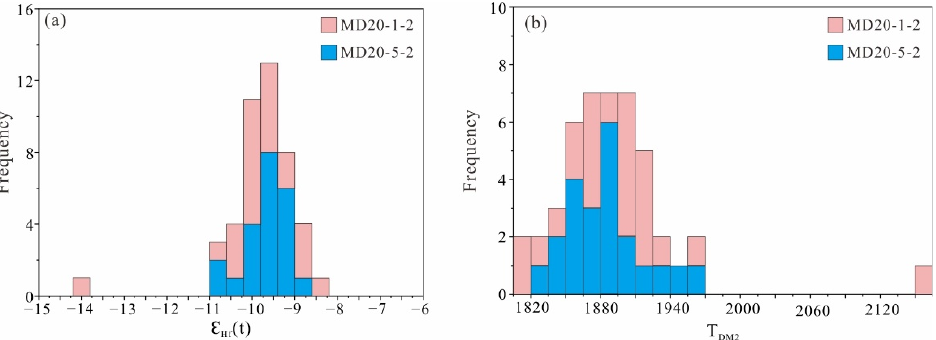
Figure 7. Chondrite-normalized REE patterns ( a ) and primitive mantle-normalized trace element patterns ( b ) for Deqin–Weixi intermediate-felsic magmatic rocks (normalizing values after [44]). Data source: [8,10–12,15,43].